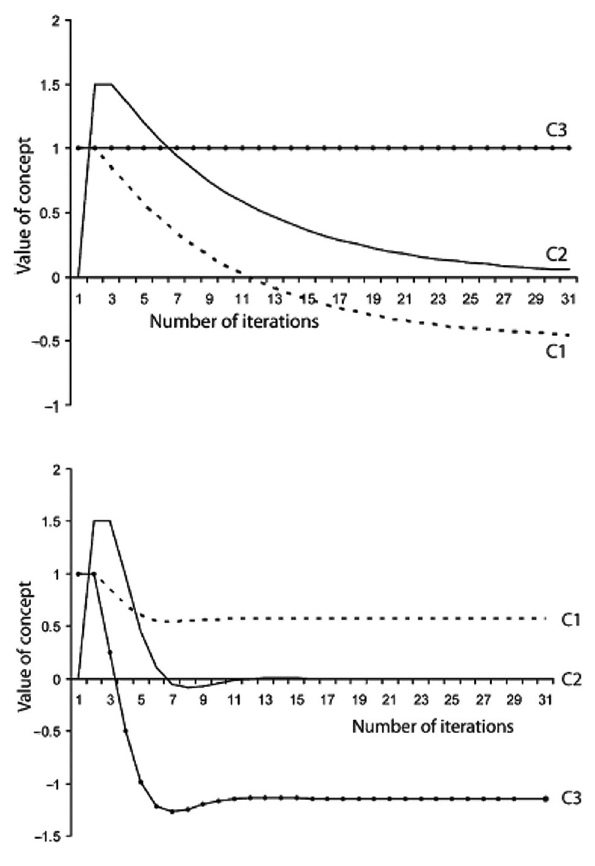
Fig. 2. FCM stabilization and value convergence points Source: Kok (2009: